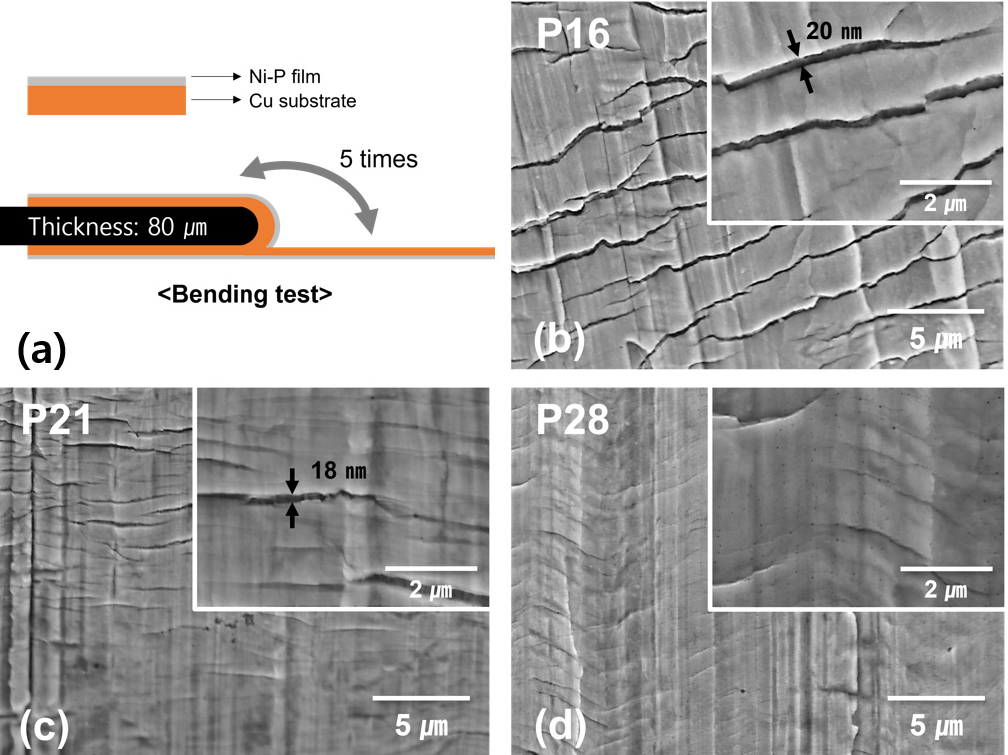
Figure 6. Bending test results for the qualitative analysis of the adhesion between the substrate and thin films: ( a ) schematic of bending test. Scanning electron micrographs of the nickel phosphide thin films after five repetitive bending cycles: ( b ) sample P16, ( c ) sample P21, and ( d ) sample P28.